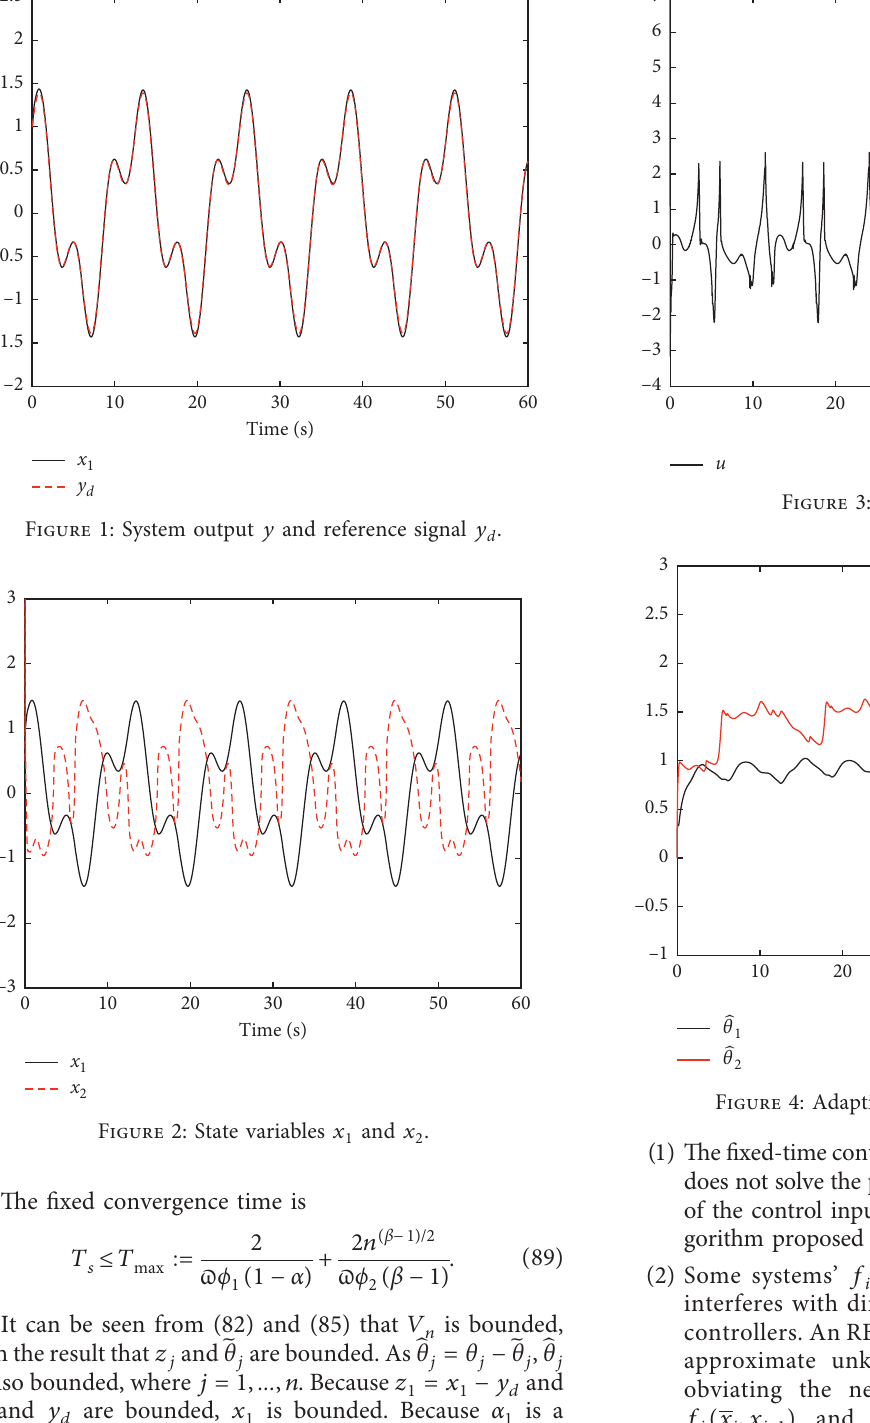
Figure 2: State variables x